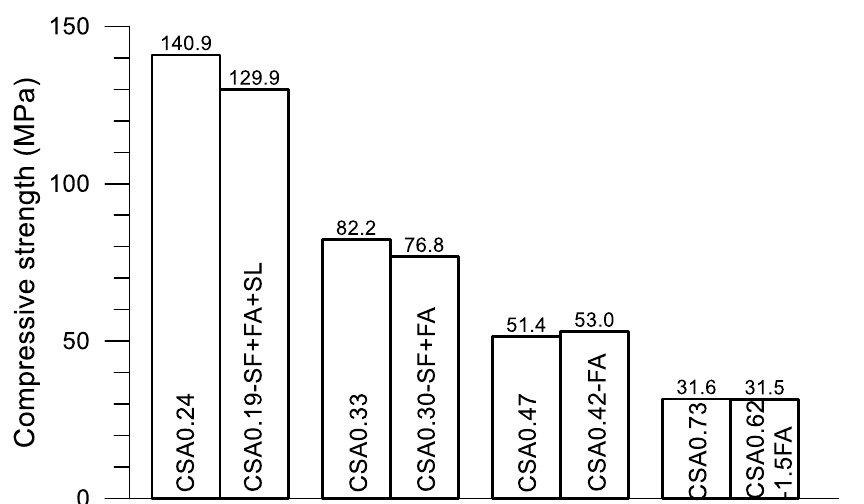
Figure 13. Compressive strength of the four pairs of CSA pastes.